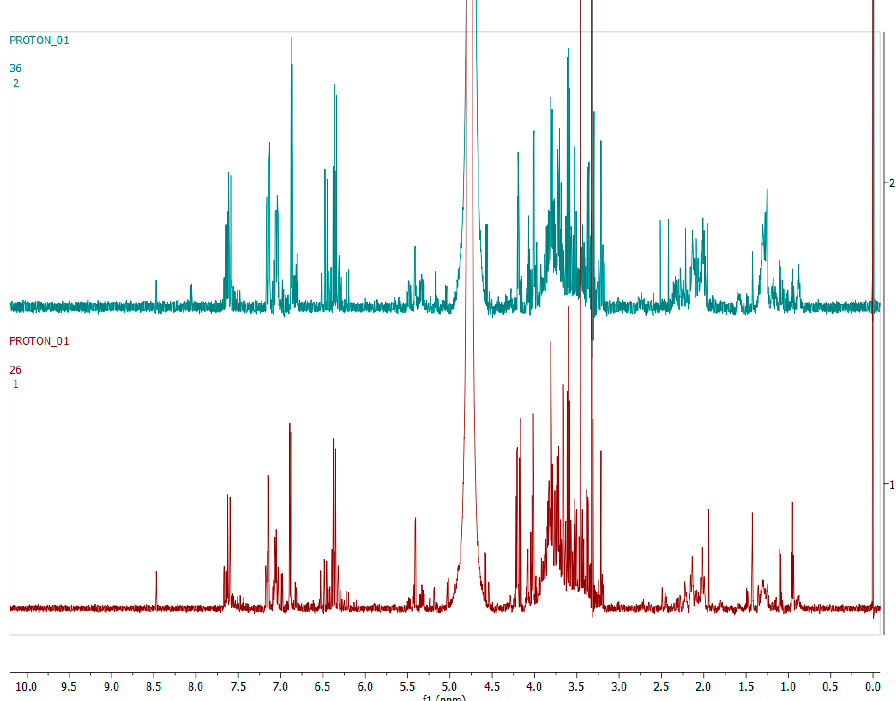
Figure 6. Comparison between samples harvested from dry sites in the autumn season across the two locations on the basis of 600 MHz 1 H-NMR spectra of H. aureonitens leaf extracts. Red—autumn season, site 3 (dry) Telperion; light blue—autumn season, site 3 (dry) Wakefield. season, site 3 (dry) Telperion; light blue—autumn season, site 3 (dry)